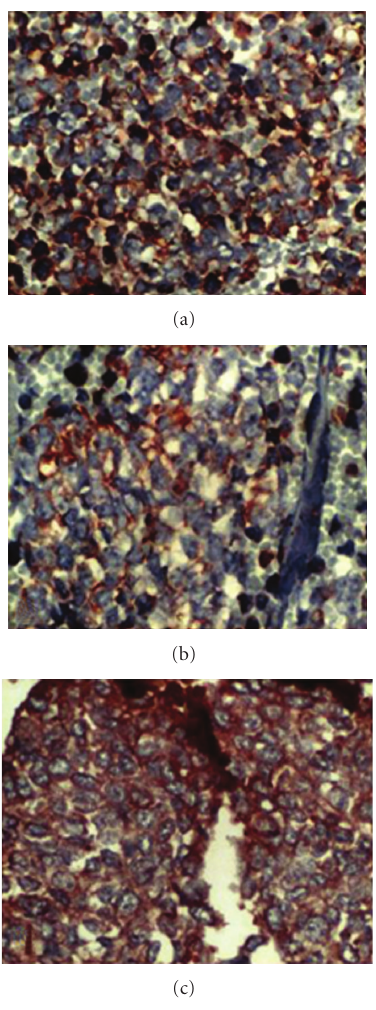
Figure 4: Immunohistochemistry revealed positivity with (a) CD 99, (b) vimentine, and (c) synaptophysin ( ×